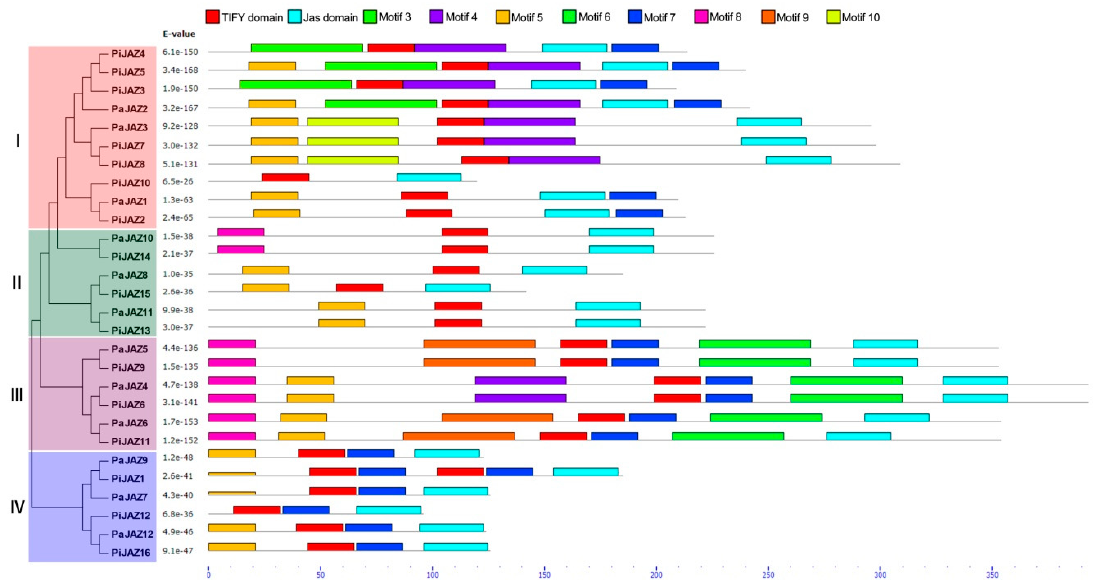
Figure 2. Analysis of motif composition in petunia JAZ proteins in the light of phylogenetic relationship. MEME database was used for motif analysis with the complete amino acid sequences of petunia JAZ proteins.